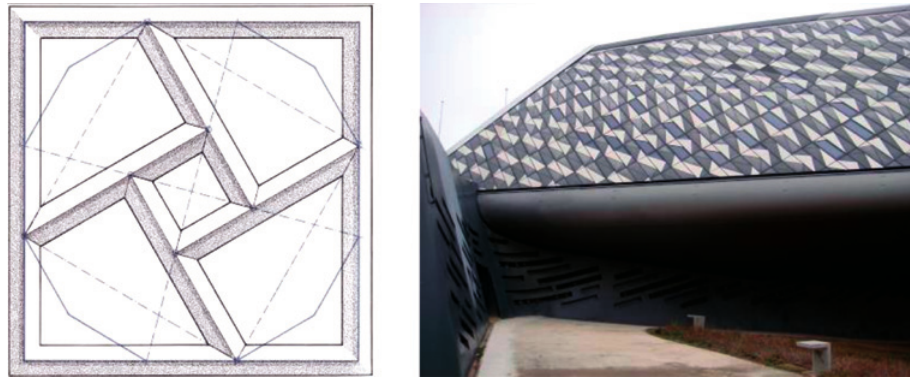
Fig. 18. Design method for creating an Fig. 19. Zaha Hadid. Expo 2008, Zaragoza,